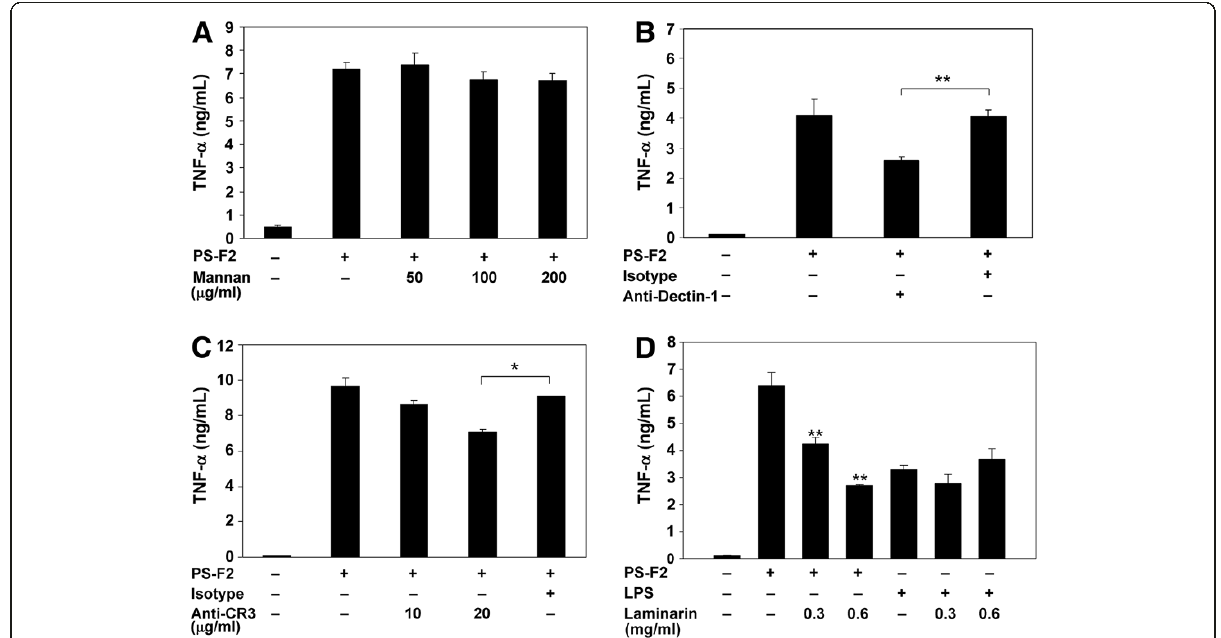
Figure 1 PS-F2 stimulates macrophage activation via Dectin-1 and CR3-mediated pathways. RAW264.7 cells were pre-incubated with or without mannan ( A ), anti-Dectin-1 antibody (2 μ g/ml) ( B ), anti-CR3 antibody ( C ), or laminarin ( D ) for 1 h and stimulated with PS-F2 (10 μ g/ml) or LPS (0.2 μ g/ml) in the presence or absence of various reagents as indicated for additional 20 h. Cells left untreated, treated with isotype rat IgG2a antibody ( B ), or isotype rat IgG2b antibody ( C ) served as controls. TNF- α concentrations in the culture fluids were determined by ELISA ( n = 3). Data shown are representative of 3 or more experiments. * P < 0.05, ** P < 0.01 versus PS-F2 stimulation alone in ( D